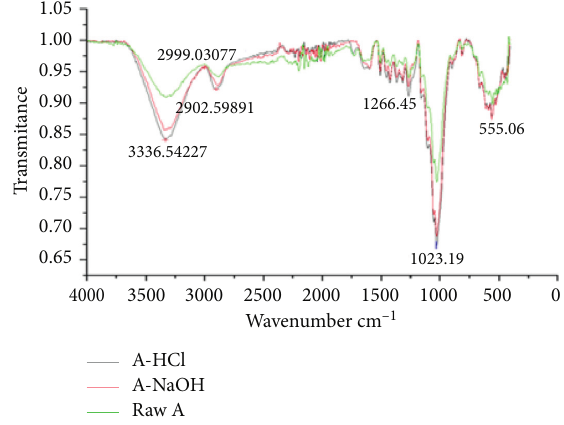
Figure 2: FTIR spectrum of raw-A, A-HCl, and A-NaOH biosorbents.